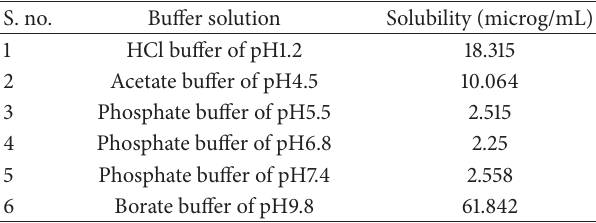
Table 3: Solubility of acyclovir in different pH buffer solutions.